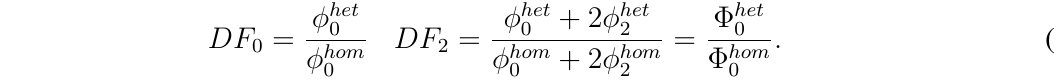
Figure 1: C5G7 Benchmark quarter core